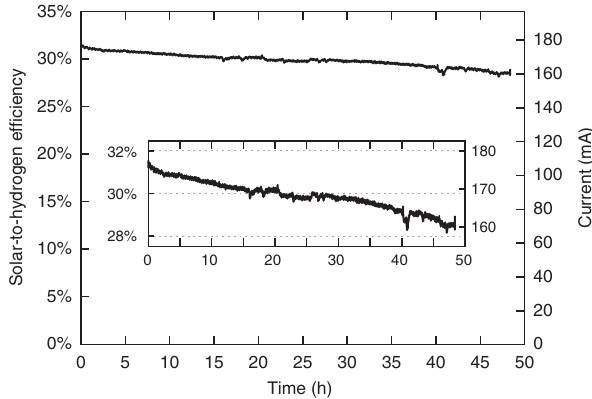
Figure 4 | STH efficiency. The STH efficiency of the PV-electrolysis system was measured over a 48h continuous operation. The right vertical axis shows the current passing through the dual electrolyser and the left vertical axis shows the corresponding STH efficiency. The inset highlights a smaller y axis range for improved